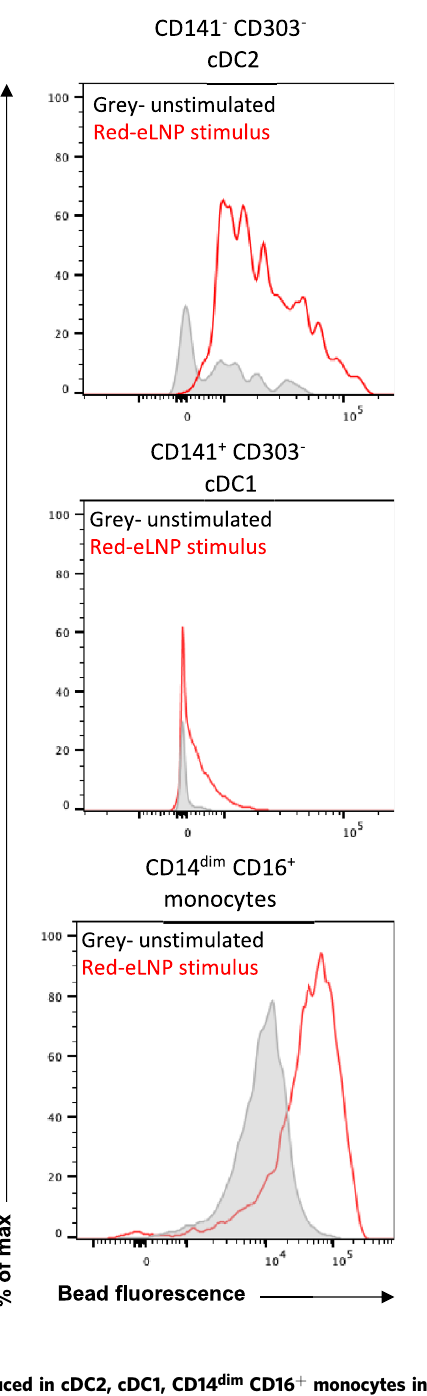
CD14 dim CD16 + monocytes from PBMCs . To determine the